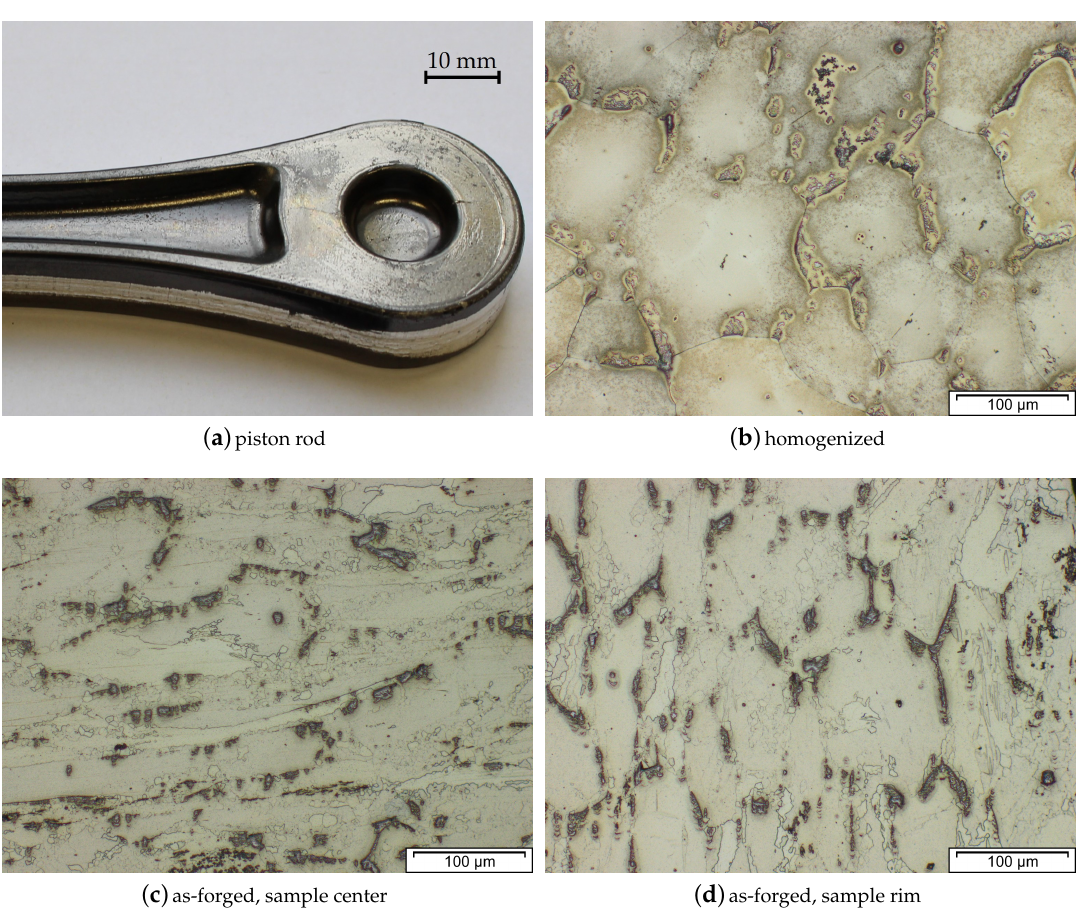
Figure 24. Finished part ( a ) and microstructures of a ZK60 variant in consecutive processing steps: ( b )homogenized at 370 ◦ C for 8h. Forging took place using a material temperature of approx. 300 ◦ C, die temperatures of 280 ◦ C and a ram speed of 10mms − 1 . The as-forged microstructures of parts cooled at air are shown in: ( c )center area having high degree of deformation and ( d )flange area with a lower degree of